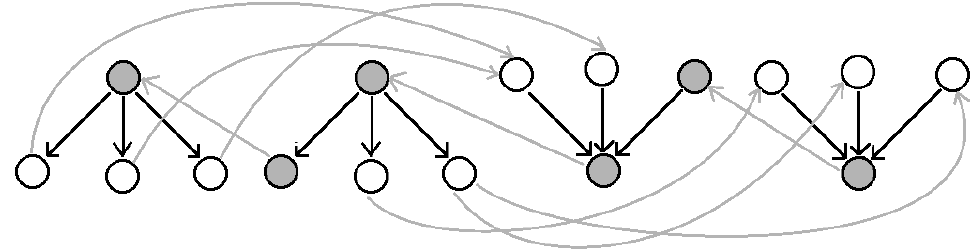
Figure 5. Introduction of max ( m − ( M − 1 ) , n − ( N − 1 )) good